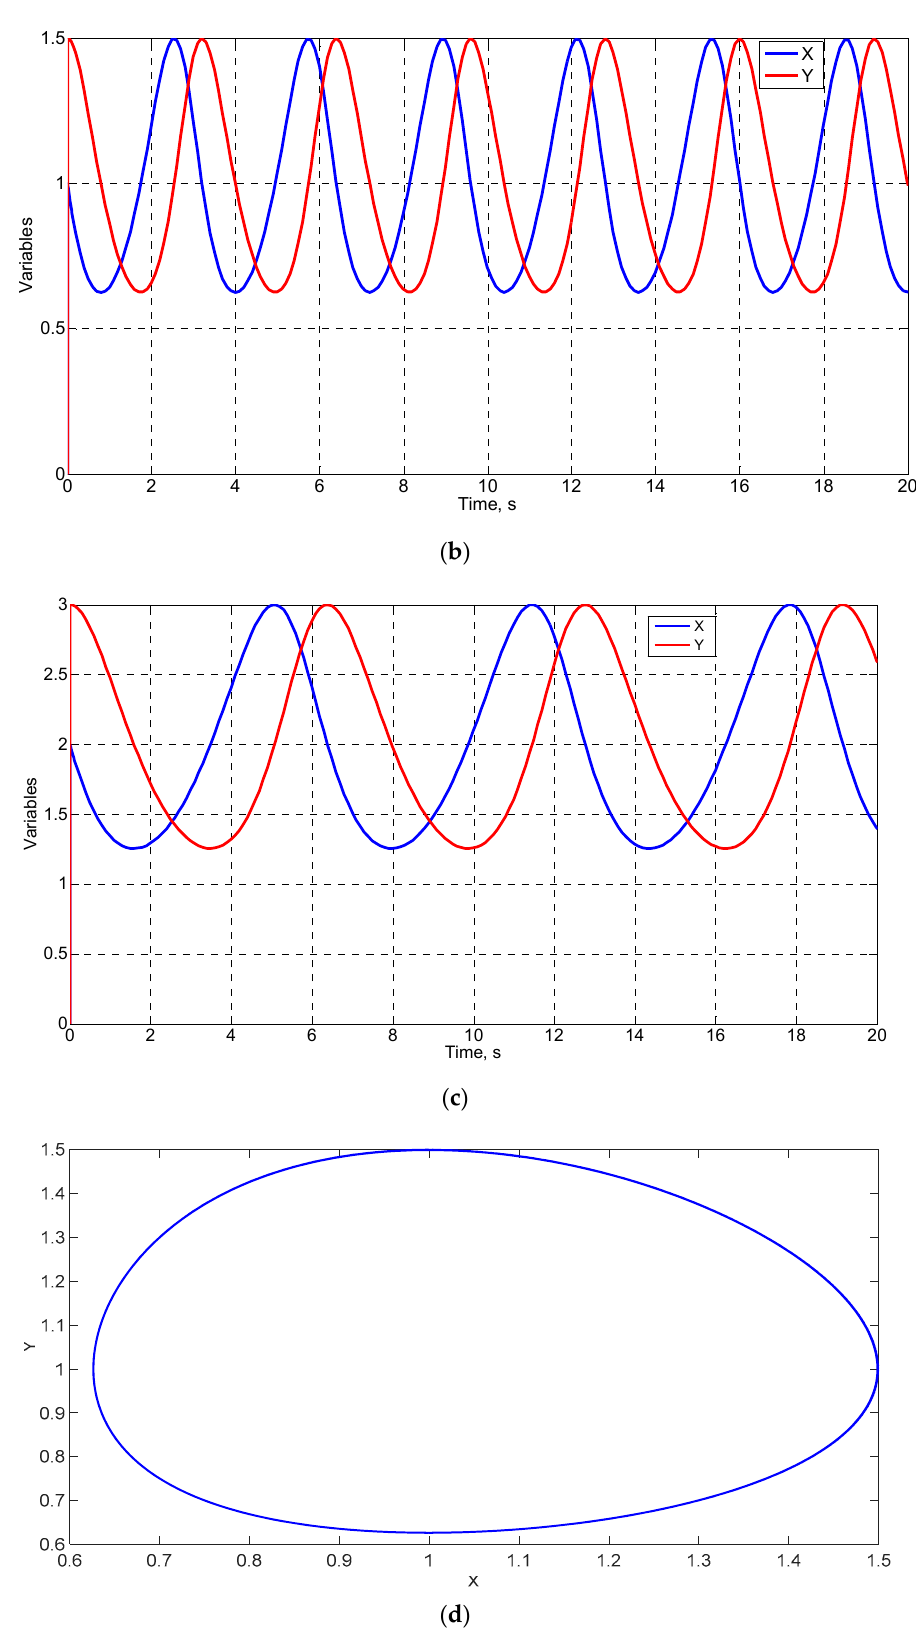
Figure 7. Concentrations of the variables x and y for case ii (Table 1). ( a ) Scenario IV, ( b ) Scenario V, ( c ) Scenario VI, and ( d ) phase plane of scenario IV.